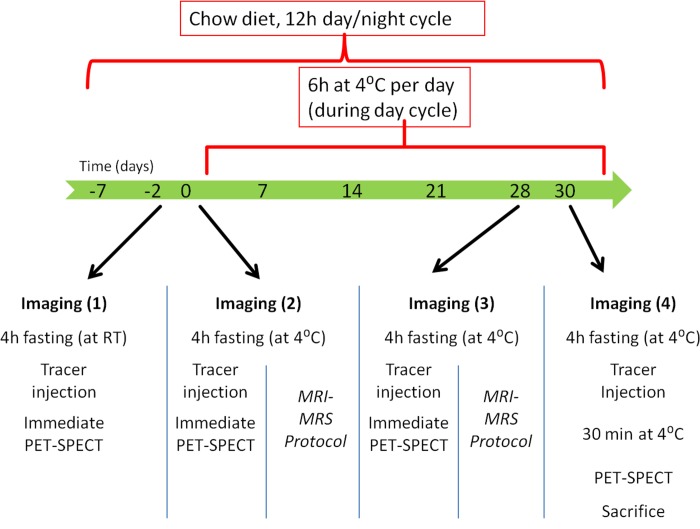
Study design.Imaging with each tracer was performed sequentially in baseline conditions (day -2), after acute cold exposure (day 0), after cold acclimation (day 28) and after tracer distribution in the cold (day 30). Additionally MRI/MRS was performed with another groupe at day 0 and day 28.